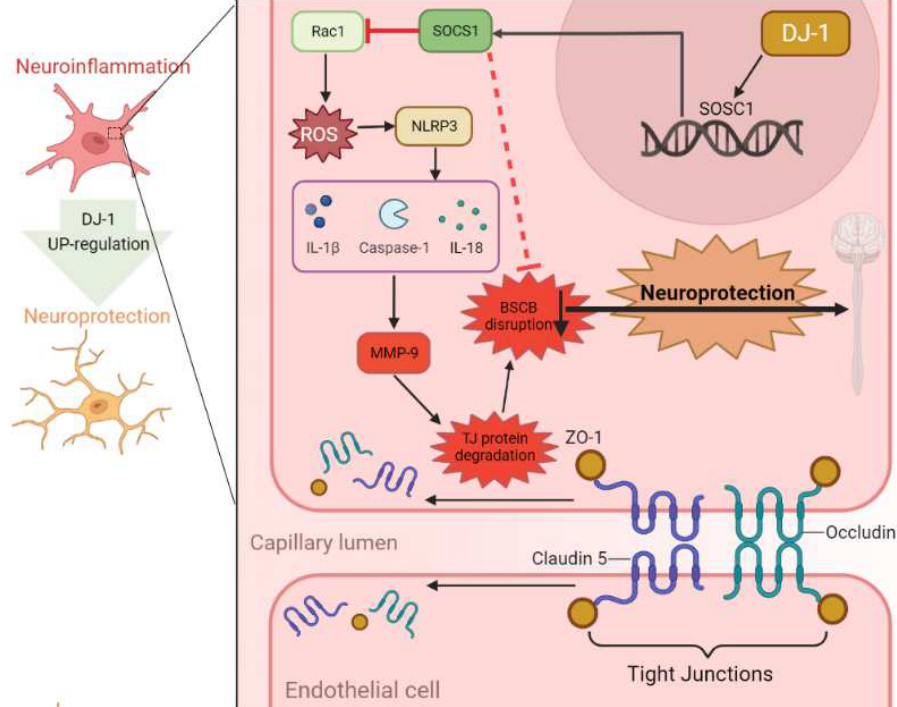
Figure 7. Schematic mechanism of neuroprotection of DJ-1 in traumatic spinal cord injury. DJ-1 alleviates neuroinflammation and the related blood-spinal cord barrier destruction by suppressing NLRP3 inflammasome activation via SOCS1/Rac1/ROS pathway.